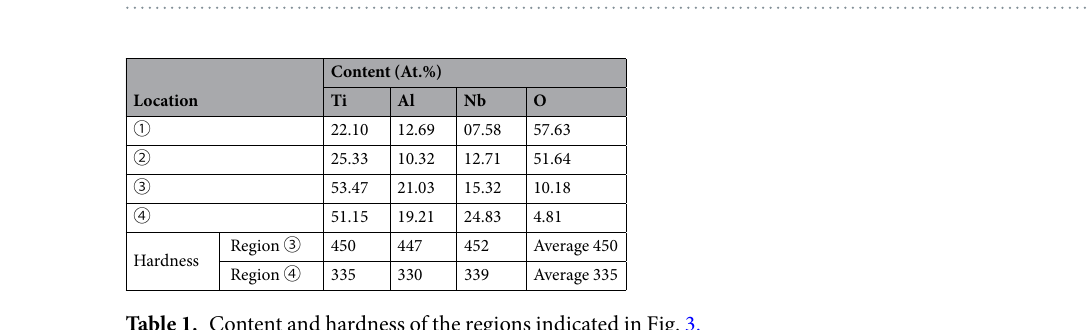
Figure 4. Formation mechanism of tear strips; ( a , b ) Rich α 2 phase layer formation process; ( c ) Tear strip formation